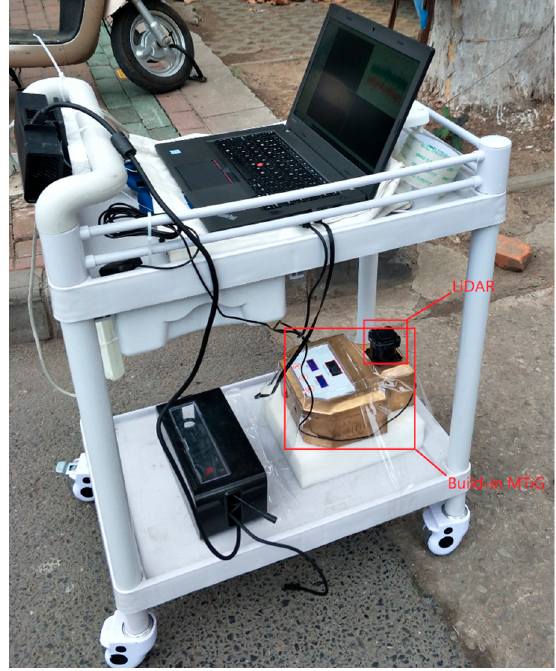
Figure 1. System hardware platform.